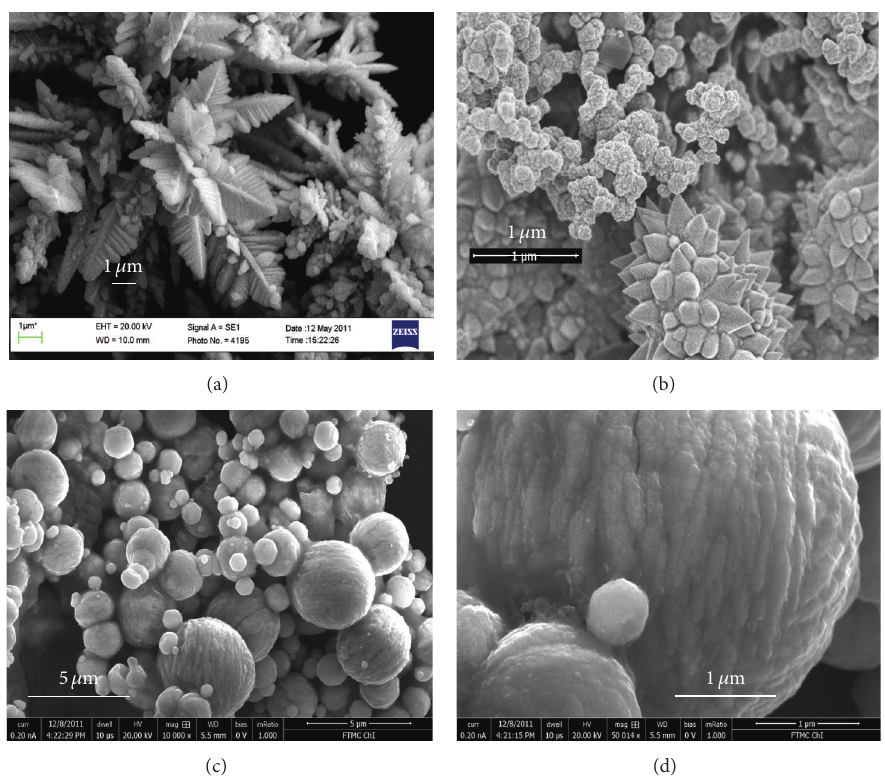
Figure 1: FESEM views of synthesized Co (a), Ru (b), and Co-Ru ((c), (d)) products by a hydrothermal way at 120 ∘ C for 10h. The solution containing 0.04 CoCl 2 , 0.004 RuCl 3 , 0.08 sodium citrate, 0.33 NaOH, and 1.7mol/L hydrazine hydrate was explored for Co-Ru fabrication, while for pure Co and Ru species, only their precursors at 0.04mol/L and the same additives as for Co-Ru synthesis were used.